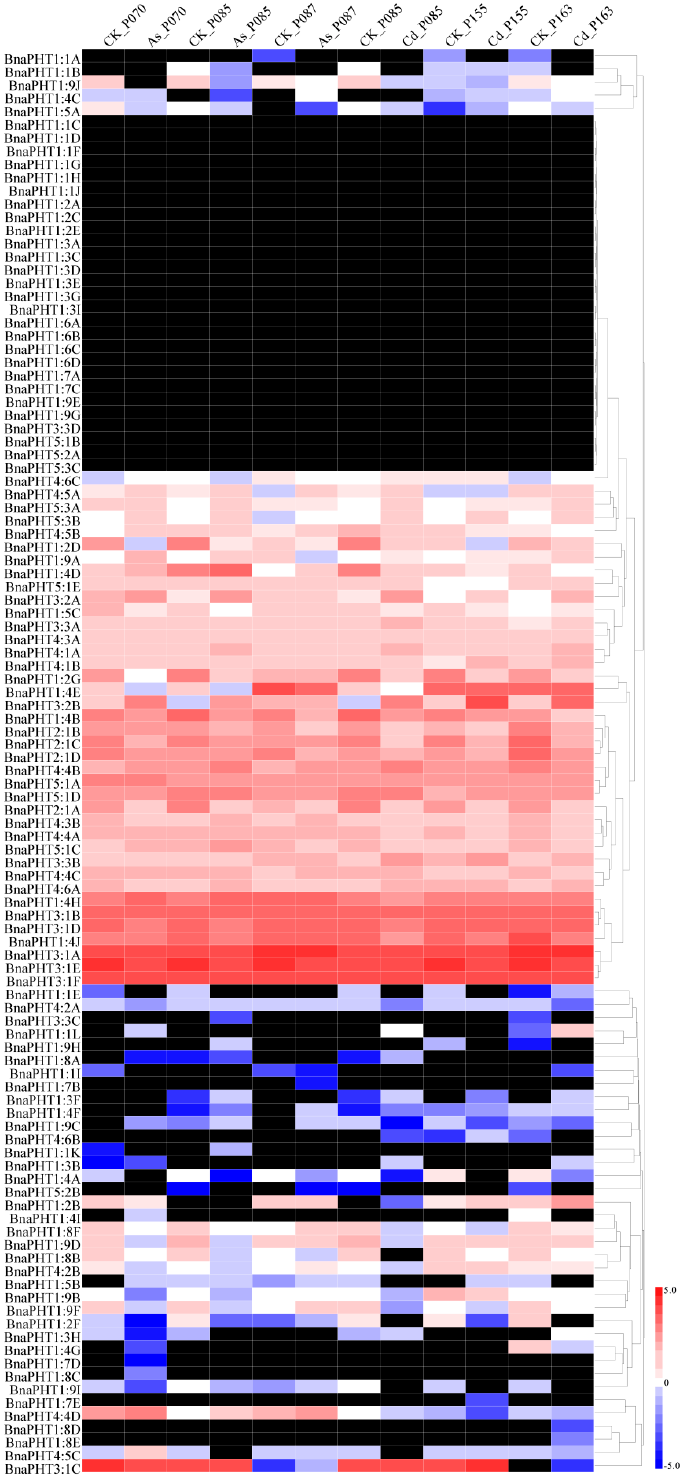
Figure 6. Heatmap of the expression profiles of BnaPHT family genes in different rapeseed accessions treated with As 3+ and Cd 2+ . The samples and treatments are shown above the heatmap. The results were obtained by RNA-seq analysis. The relative expression values in the bars were calculated based on FPKM values (fragments per kilobase of exon model per million) compared to the control samples. The heatmap was generated using Heatmap Illustrator 1.0 (HemI 1.0). The black indicates that the BnaPHT had no expression (FPKM = 0) levels in this study (Table